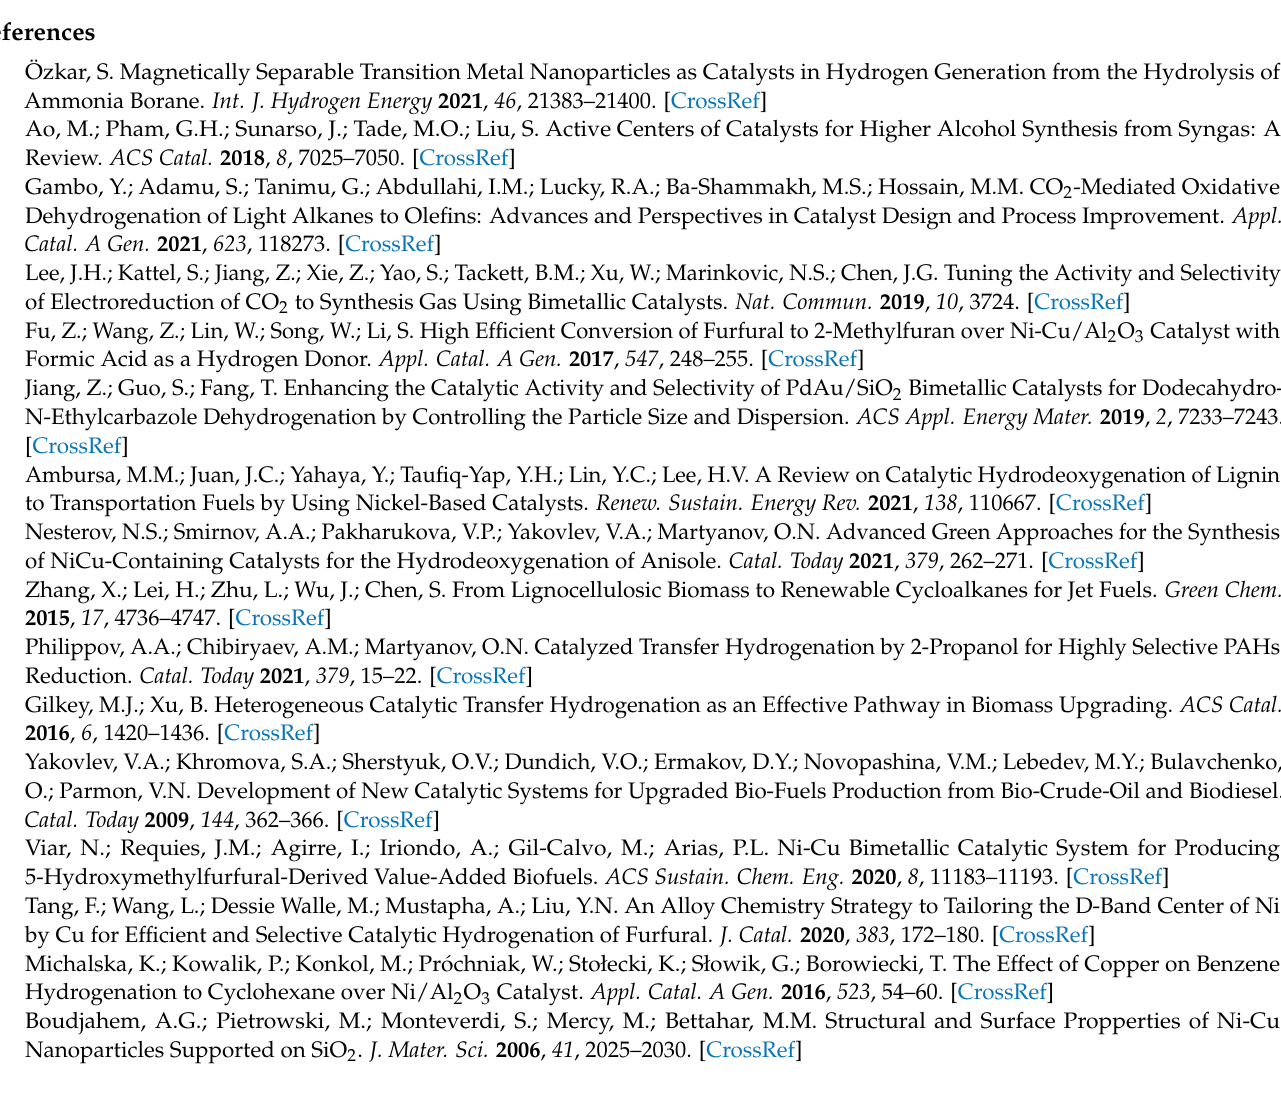
acetone; Table S3: Rate constants of product formation in the experiments at 150 ◦ C. The constants were calculated using the least squares method with a kinetic model that would take into account the effect of acetone concentration on the rate of catalytic transformations, m(catalyst) = 0.36–0.37 g; Figure S2. Examples of chromatograms of an initial reaction mixture (A) and a final reaction mixture